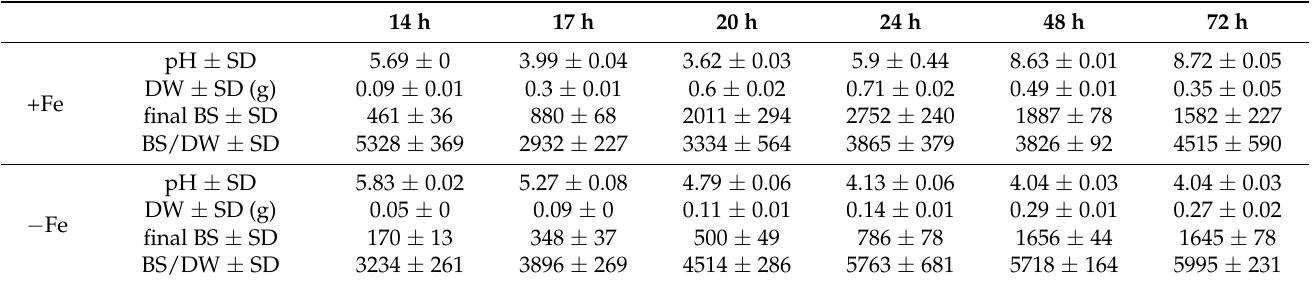
Figure 2. CGQ-mediated growth monitoring of A. fumigatus AfS77 during 14–72 h liquid shake culturing under +Fe and − Fe conditions. A. fumigatus AfS77 was cultured for 14 h, 17 h, 20 h, 24 h, 48 h, and 72 h in liquid shake cultures under − Fe and +Fe conditions in biological triplicates and biomass was monitored with the CGQ. The different colors discriminate the cultivations conducted for different incubation times. Thin lines display growth dynamics of individual runs and shaded areas show the variance within the parallels of each experiment. Thick lines represent a smooth curve fitted by local polynomial regression using the LOESS algorithm with a span value of a = 0.3. Table 1. Comparison of DW, BS values, BS/DW ratios, and pH values of A. fumigatus AfS77 cultured for 14–72 h under +Fe and − Fe conditions. Mean ± standard deviation of biological triplicates is